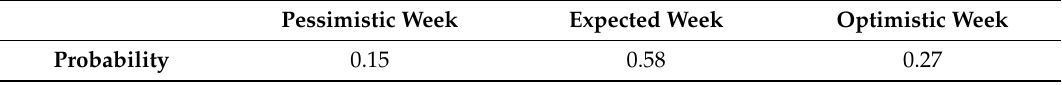
Table 2. Benchmark Probabilities characterization: pessimist, expected and optimist.